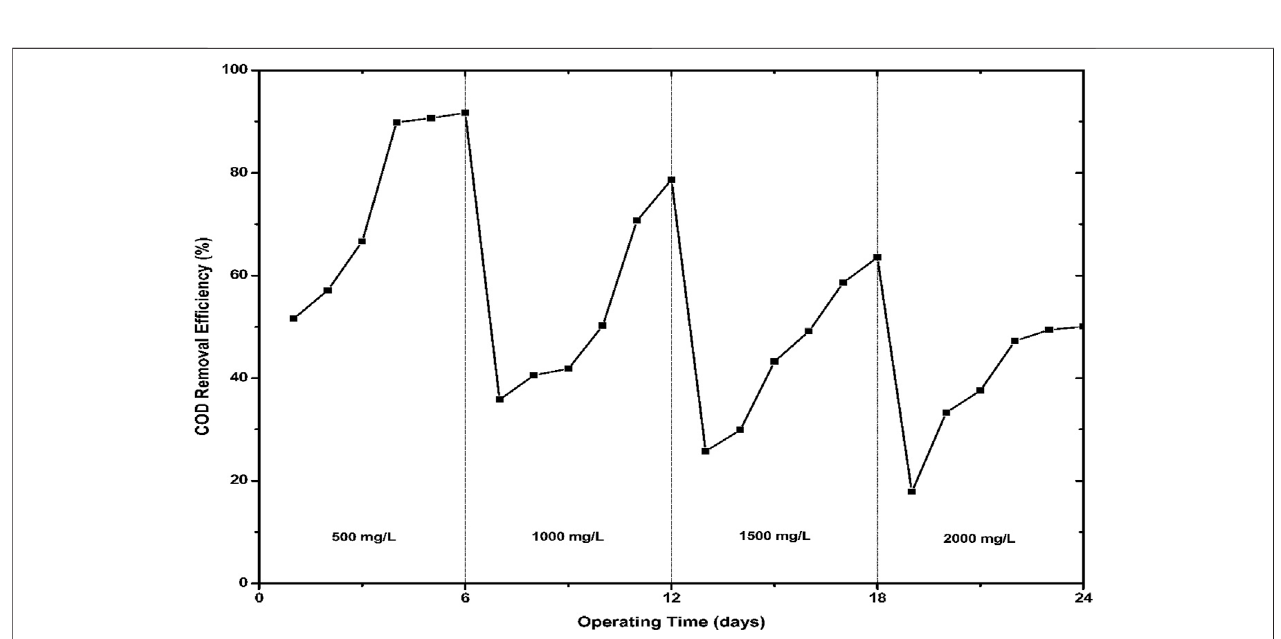
FIGURE 6 | COD level and the corresponding COD removal (%) in the synthetic wastewater by the PBBR.